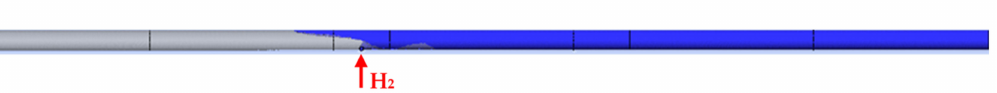
Figure 8. Simulation of H 2 leakage into the evaporation zone at the new geometry, taking into account temperatures (side view); (blue—H 2 profile, grey—N 2 profile).